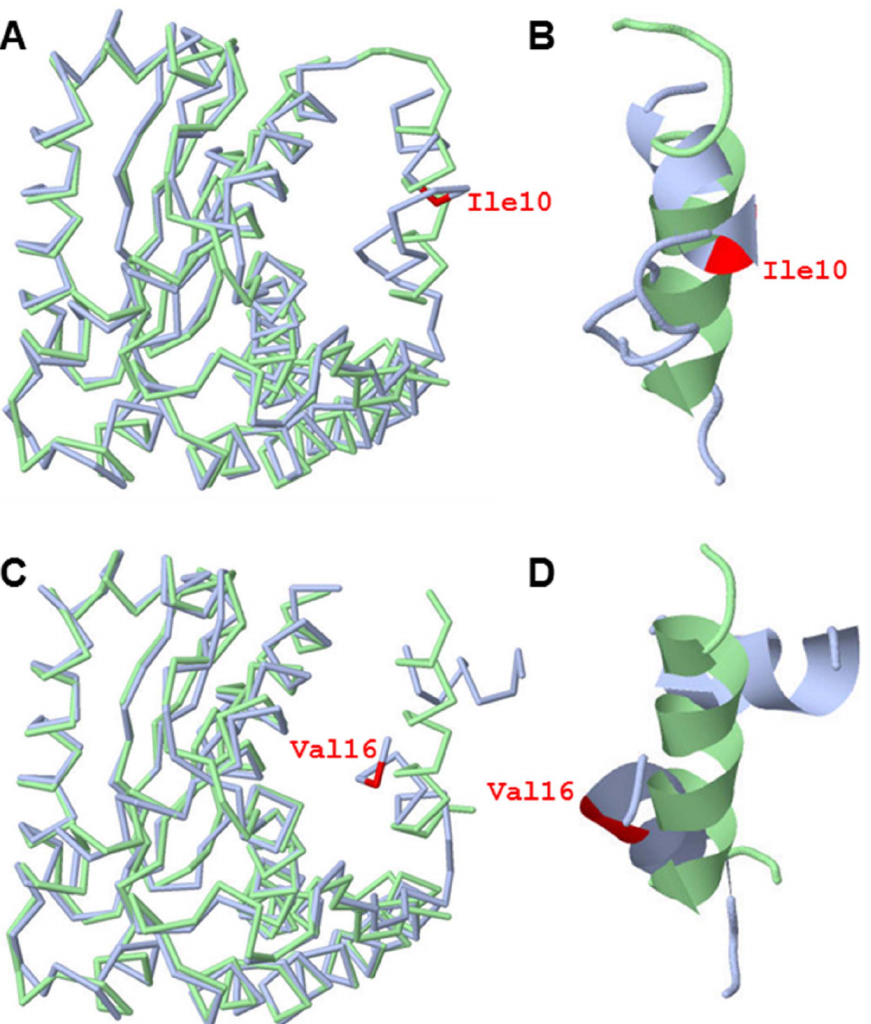
Figure 3. Superimposed native structures (green) and mutant structures (blue) of the SOD2 produced using abinitio modelling. A) S10I (S-15I) mutation highlighted in red. B) This mutation disrupts the alpha helix, RMSD: 2.02. C) A16V (A-9V) mutation highlighted in red. D) This mutation disrupts the alpha helix, RMSD: 1.94.